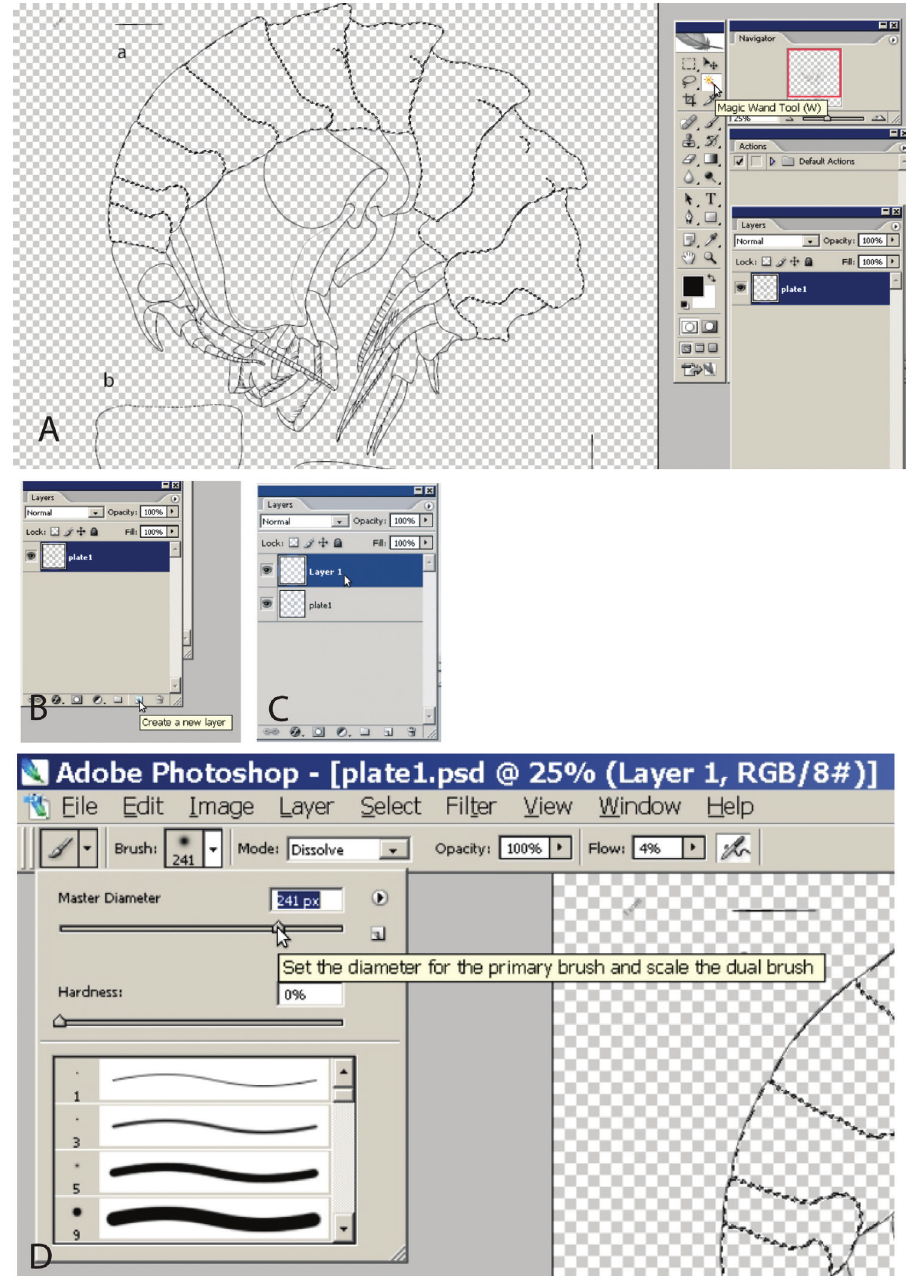
Figure 2. A) In Photoshop use “Magic Wand Tool” and the “shift” key to mark areas in the drawing for shading. B) Create a new layer, by clicking on second icon from the right in the icon bar at the lower end of the window. C) Select the newly created layer before applying the shading. D) Select “Brush”, modify “Master Diameter” and set “Flow” at about